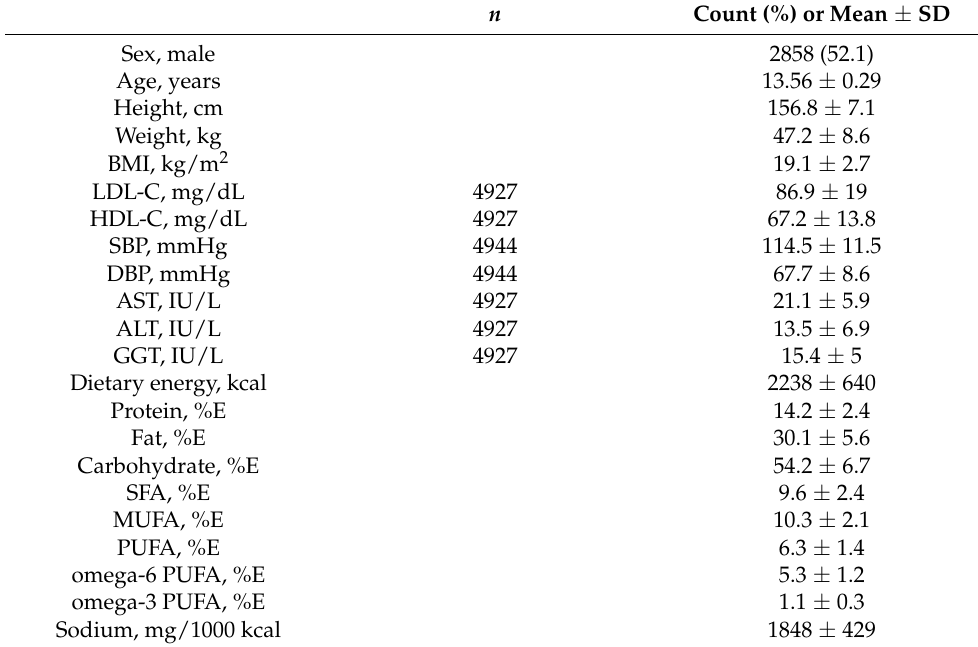
Table 1. Characteristics, health risks, and dietary intake of subjects.